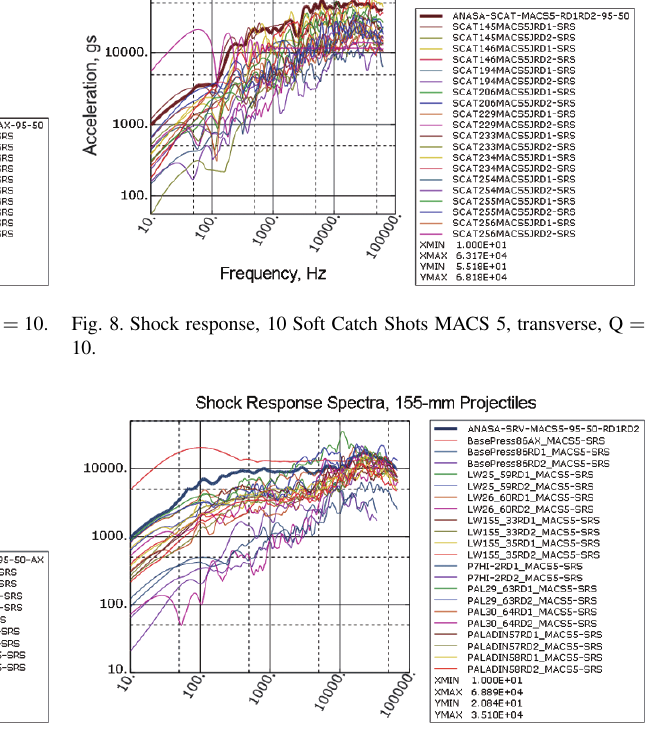
Fig. 10. Shock response spectrum for 9 near-tactical shots, transverse, Q =